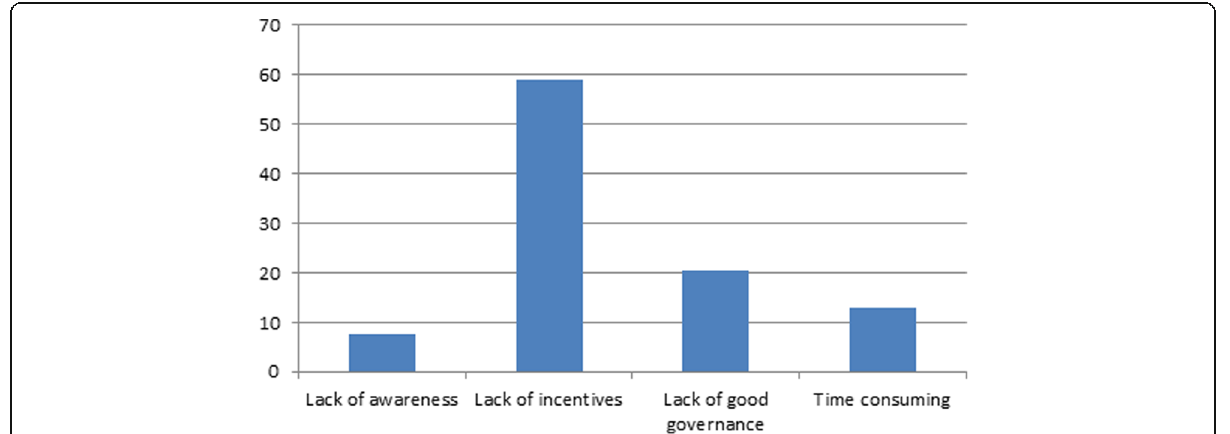
Fig. 3 Farmers ’ reasons for not participating in watershed management programs in